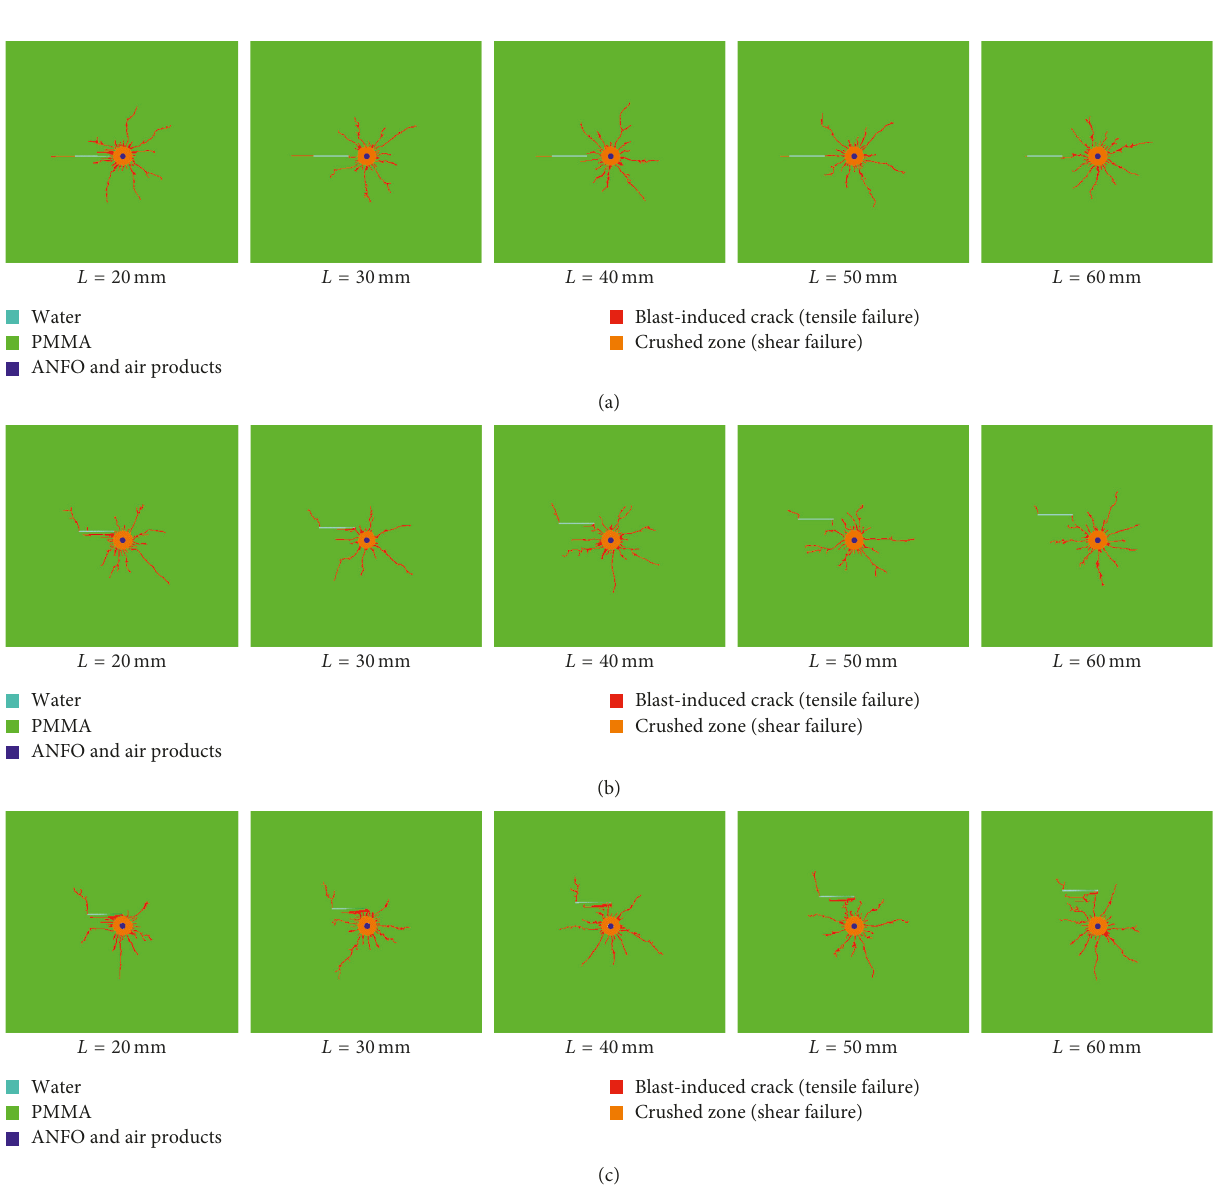
Figure 12: Material status of water-filled PMMA after explosion. (a) θ � 0 ° ; (b) θ � 45 ° ; (c) θ � 90 °